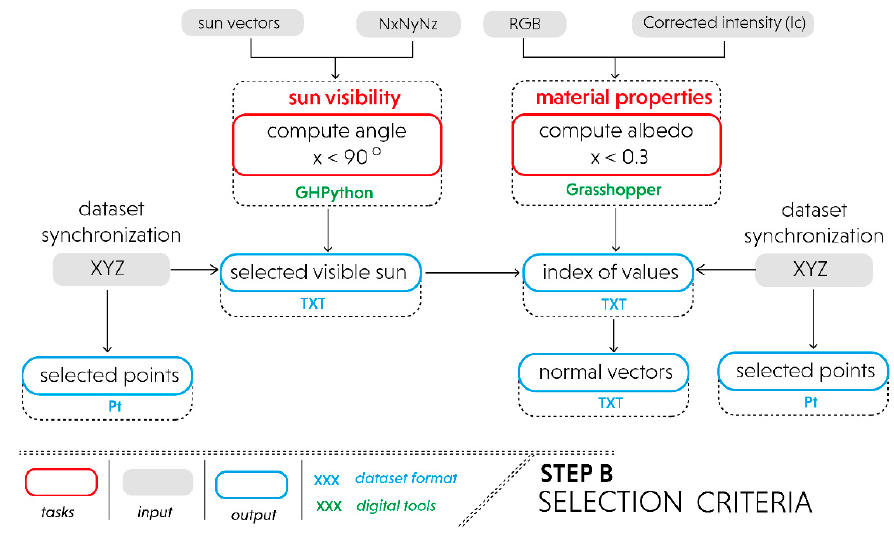
Figure 4. Selection procedures based on the criteria of sun visibility and material properties.